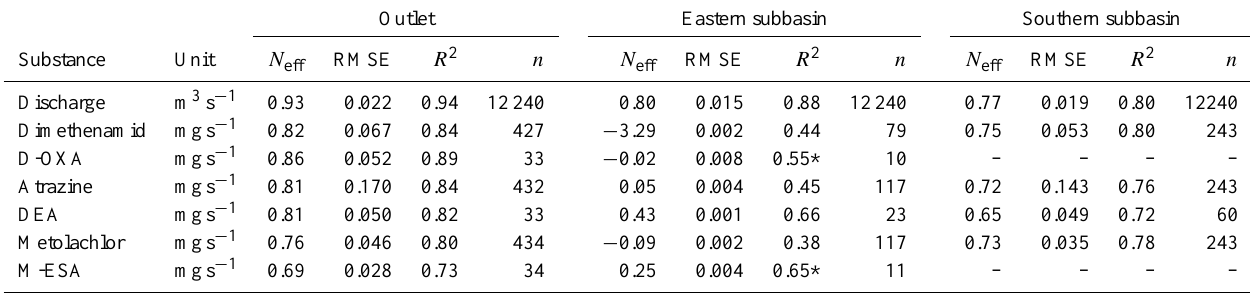
Table 3. Goodness-of-fit values for pesticide and TP modelling. n is the number of data points involved, N eff the Nash–Sutcliffe efficiency, RMSE the root mean square error and R 2 the coefficient of determination ( p < 0 . 001 unless otherwise specified).